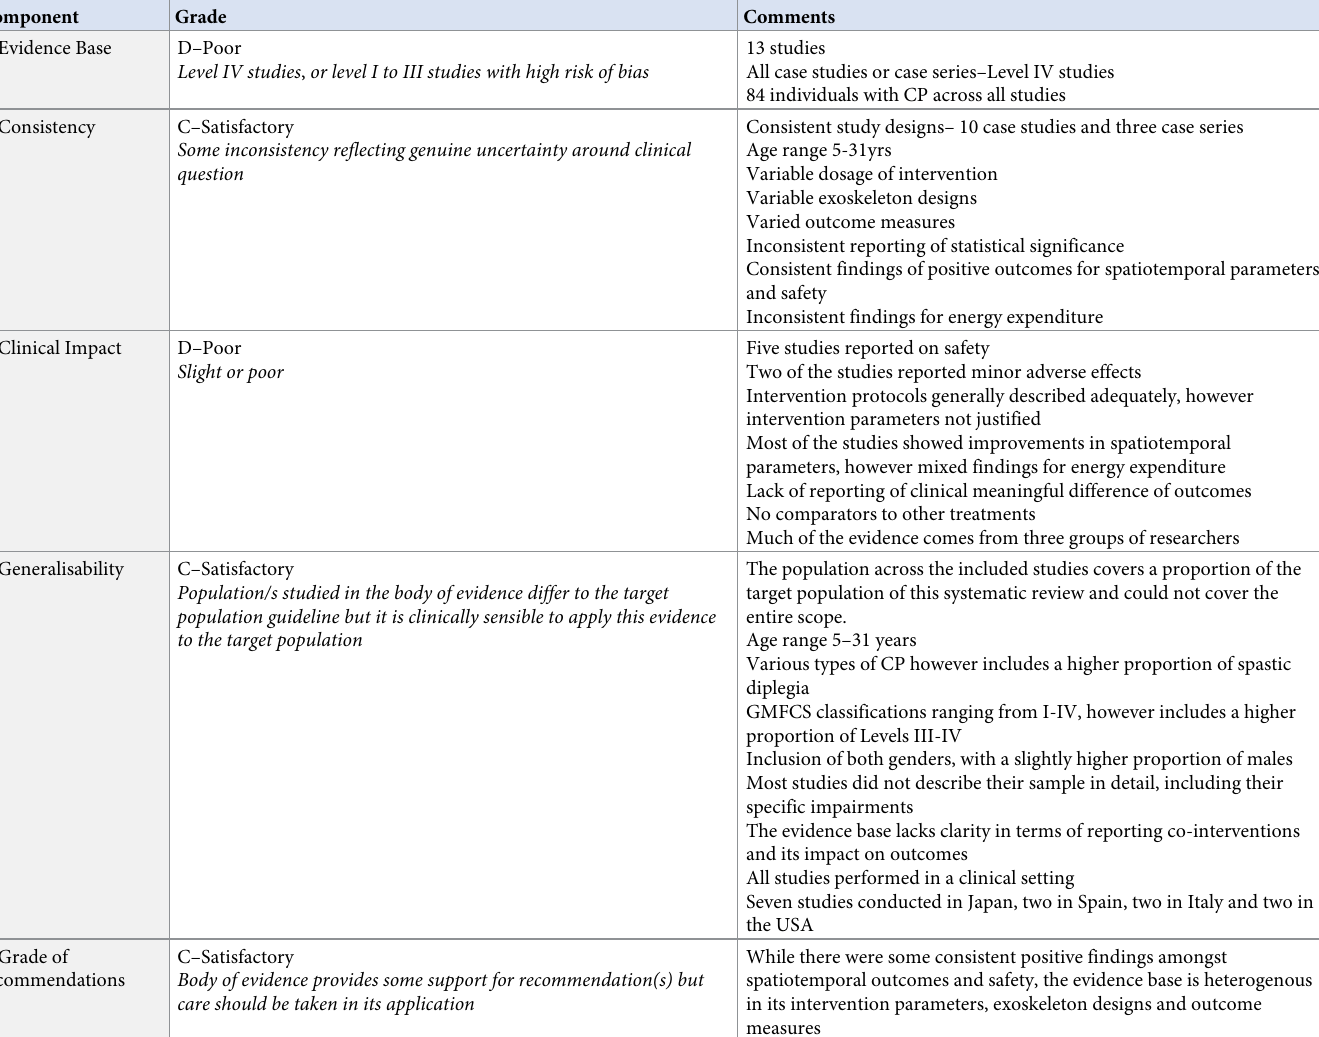
Table 5. NHMRC FORM framework